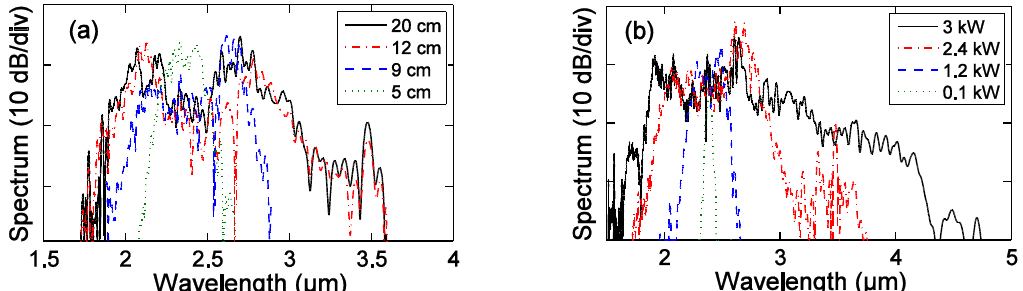
Figure 11. Evolution of experimental SC spectra recorded at the output of the tellurite step-index fiber with a core diameter of 3.5 µm (i.e., with two ZDWs) when pump wavelength is fixed to 2300 nm. ( a ) Evolution as a function of fiber length for an input peak power of 2.2 kW. ( b ) Evolution as a function of input peak power for a fiber length of 12 cm.